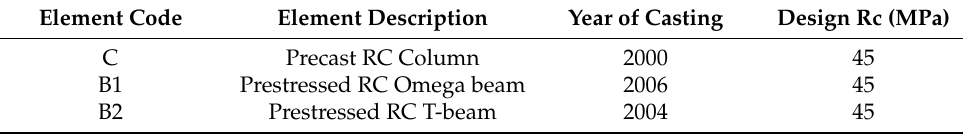
Figure 3. Prestressed RC-T-beam “B2”; red circles show the location of coring sites. Table 1. Year of casting and design concrete strength of the studied